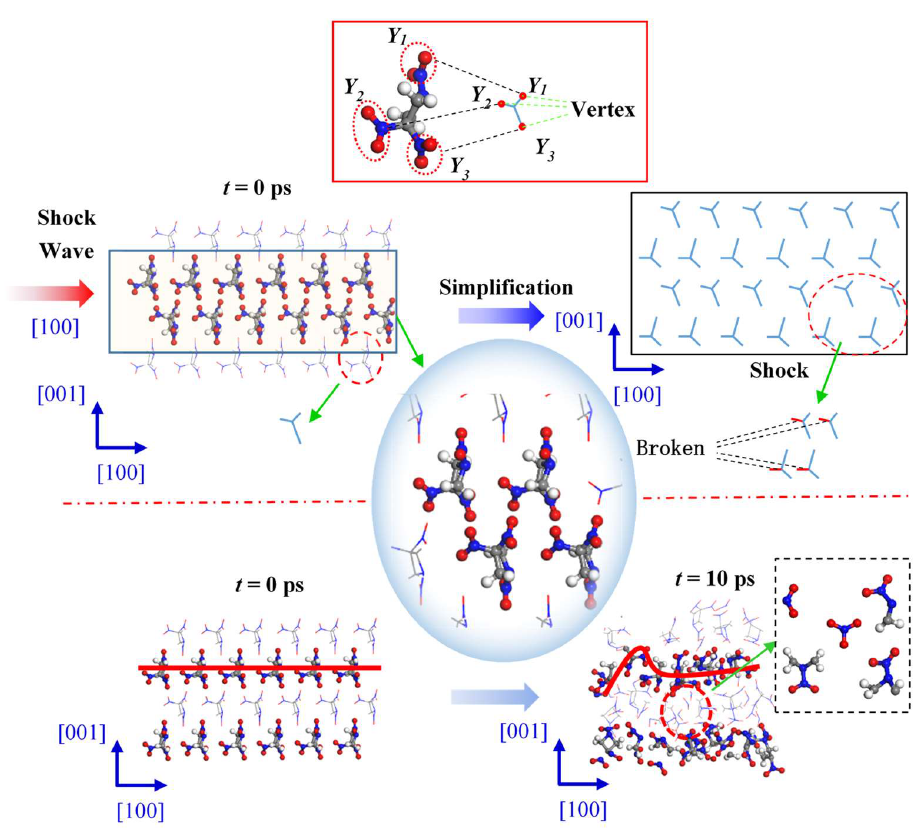
Figure 5. Molecular arrangement of TNAZ in the [100] direction.